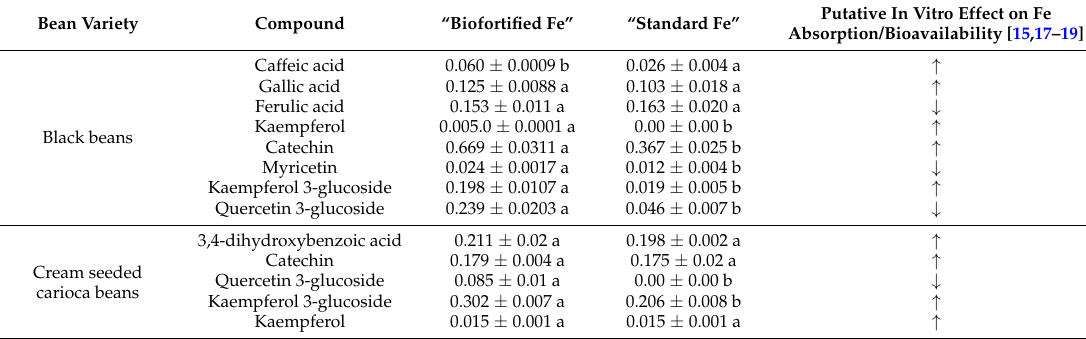
Table 7. Concentrations of prevalent polyphenols observed in cream seeded carioca beans and black beans seed coat 1 ( µ mol/g) [15,17].